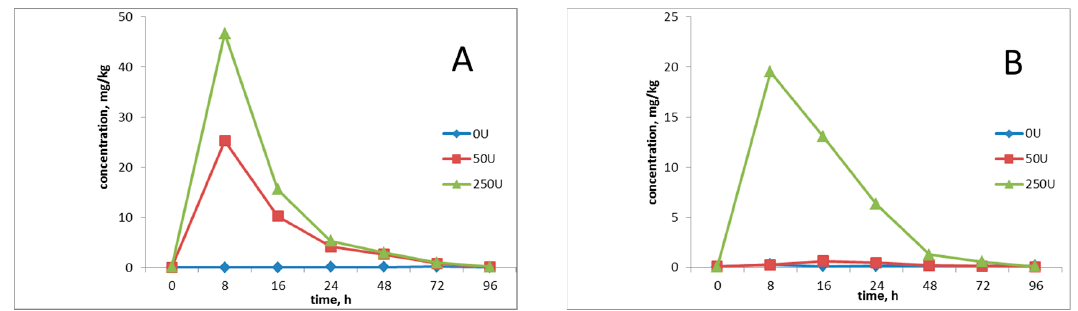
Figure 1. Distribution of NP in serum ( A ) and urine ( B ) in rats. NP concentrations below the limit of determination considered 0.